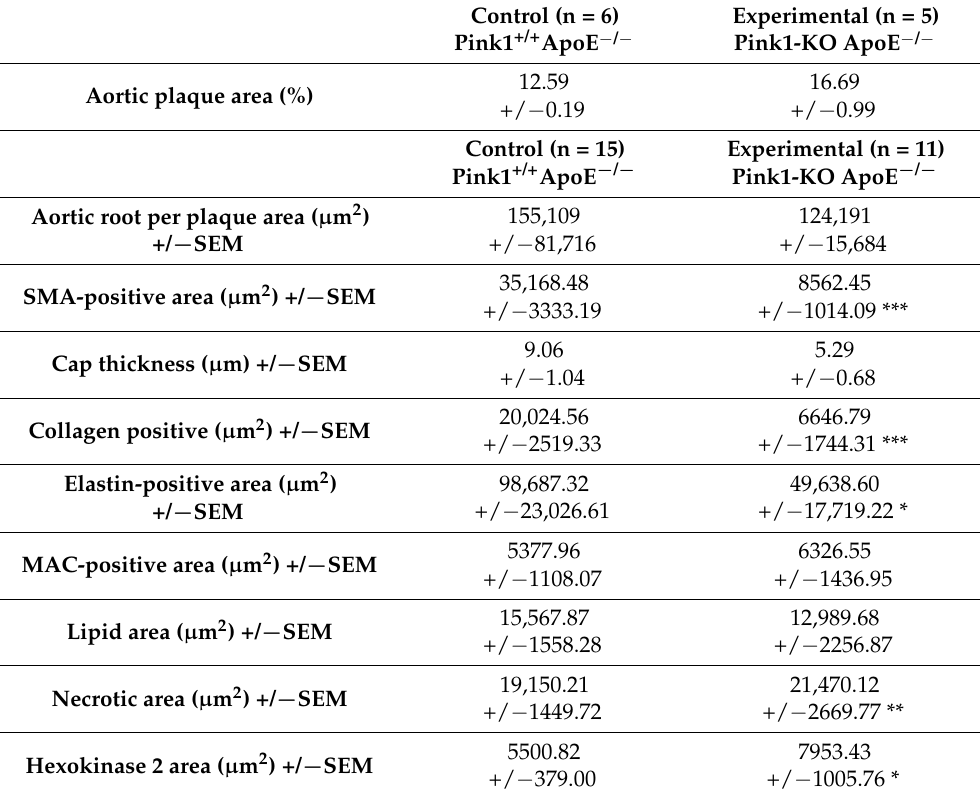
Table 1. Atherosclerosis histology Pink1-KO ApoE − / − . Left columns atherosclerotic plaque areas SMA, Mac, cap thickness, collagen, elastin areas, lipid void area, necrotic area and areas with positive hexokinase 2-stained areas in control and Pink1-KO mice. Data are +/ − SEM, * p ≤ 0.05, ** p ≤ 0.01, *** p ≤ 0.001 for control mice vs. Pink1-KO